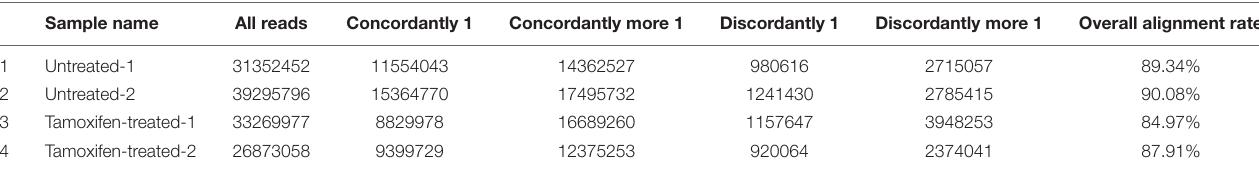
FIGURE 6 | Study of the cell distribution in different cell cycle stages. (Left) MCF-7 cells incubated with tamoxifen, and (Right) control cells. The bell-shaped curves from left to right correspond to the G1, S, G2/M phases of the cell cycle in the control and cells incubated with tamoxifen. Incubation of cells with tamoxifen did not significantly shift the distribution of the cells in different phases of the cell cycle compared with control. As in the treated group, there were minor increases, about 10 and 6%, in the S and G2 phases of the cell cycle, respectively. TABLE 1 | Evaluation of valid reads mapped to the reference genome of each